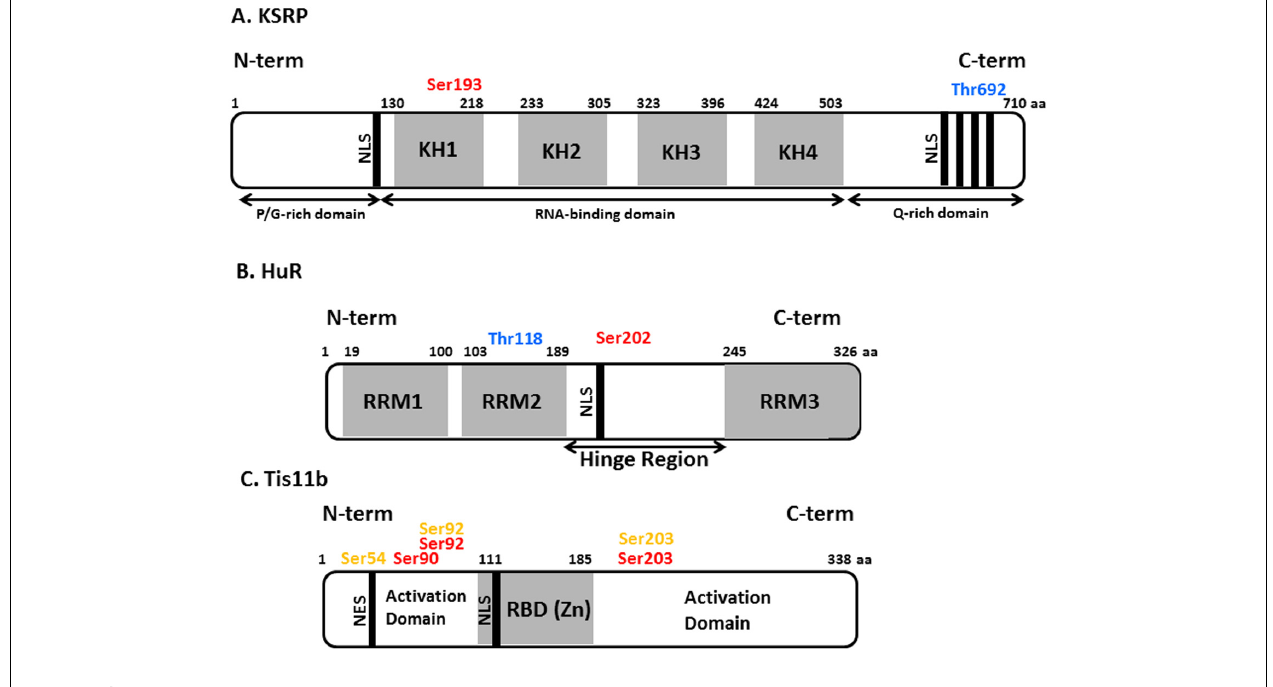
NLS); RNA recognition motifs (RRM) and their corresponding amino acid positions are depicted. (C) Activation domains on N- and C-terminal ends, NLS, nuclear export sequence (NES), and RBD (RNA-binding domain) are shown.The experimentally determined phosphorylation sites on RBPs are given colors in following manner, red: PKB phosphorylation sites, blue: p38 phosphorylation sites, yellow: MK2 phosphorylation